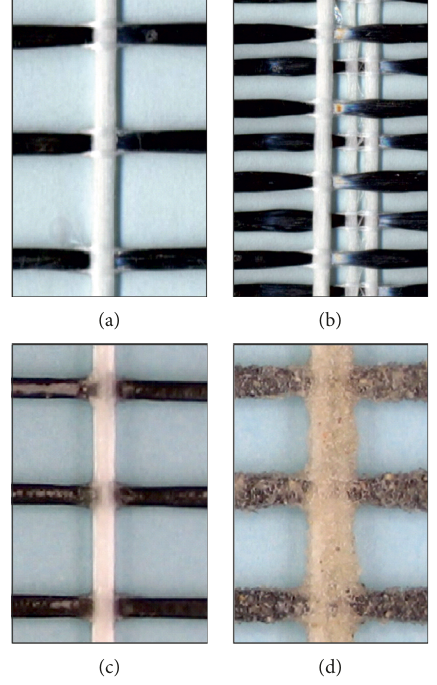
Figure 15: Tested textiles of the 2nd batch. (a) Reference